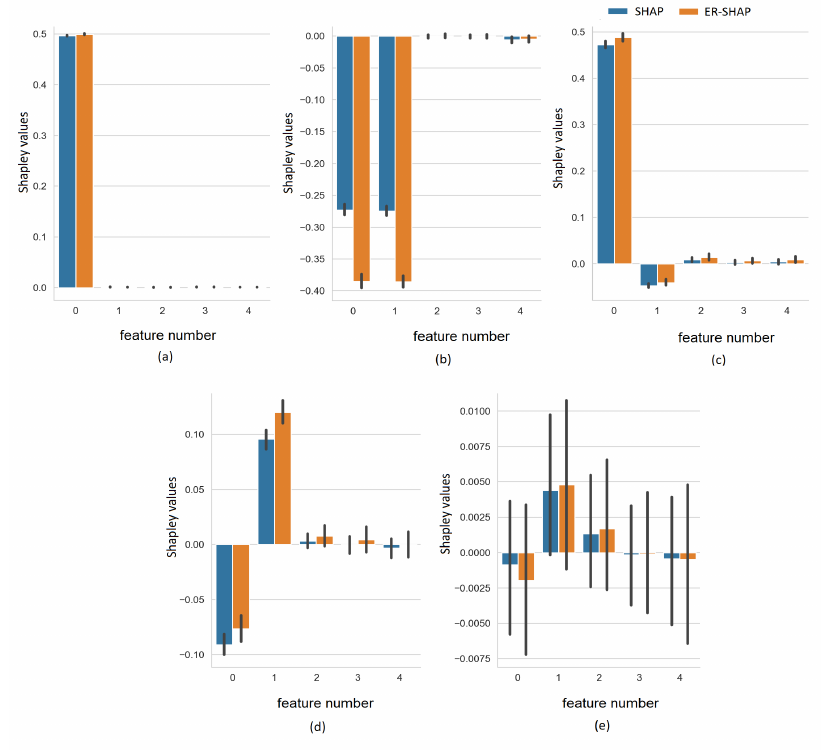
Figure 14. Shapley values obtained by means of SHAP and ER-SHAP-RF for all features of five datasets depicted in corresponding Figure 4a–e and trained